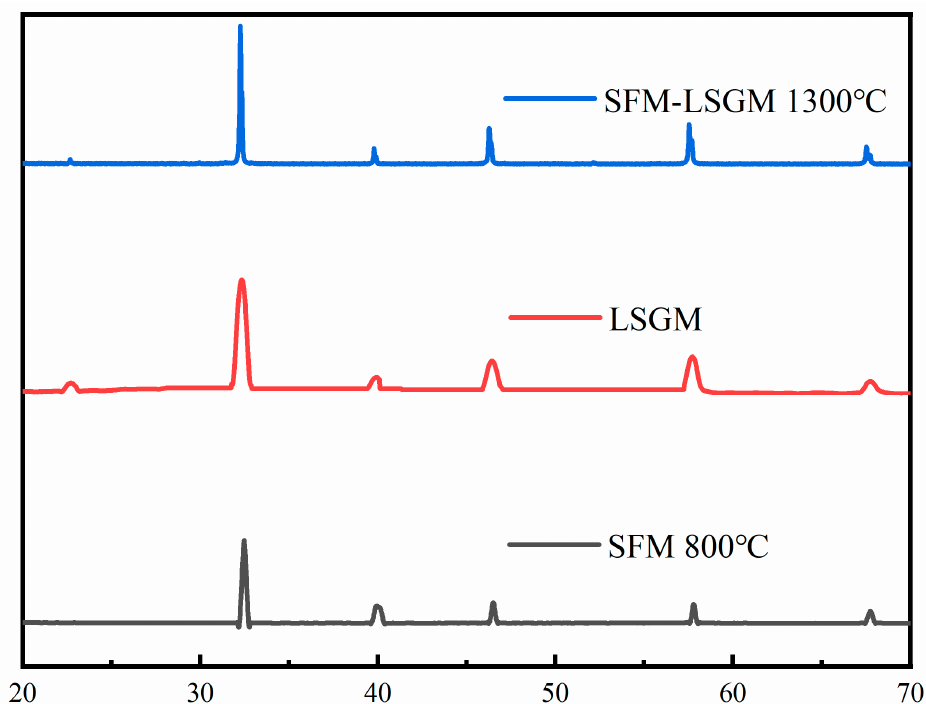
Figure 3. X-ray diffraction patterns of SFMO nanofibers, LSGM powder (commercial), and SFM–LSGM powder mixture after being fired at 1300 ◦ C for 6 h.